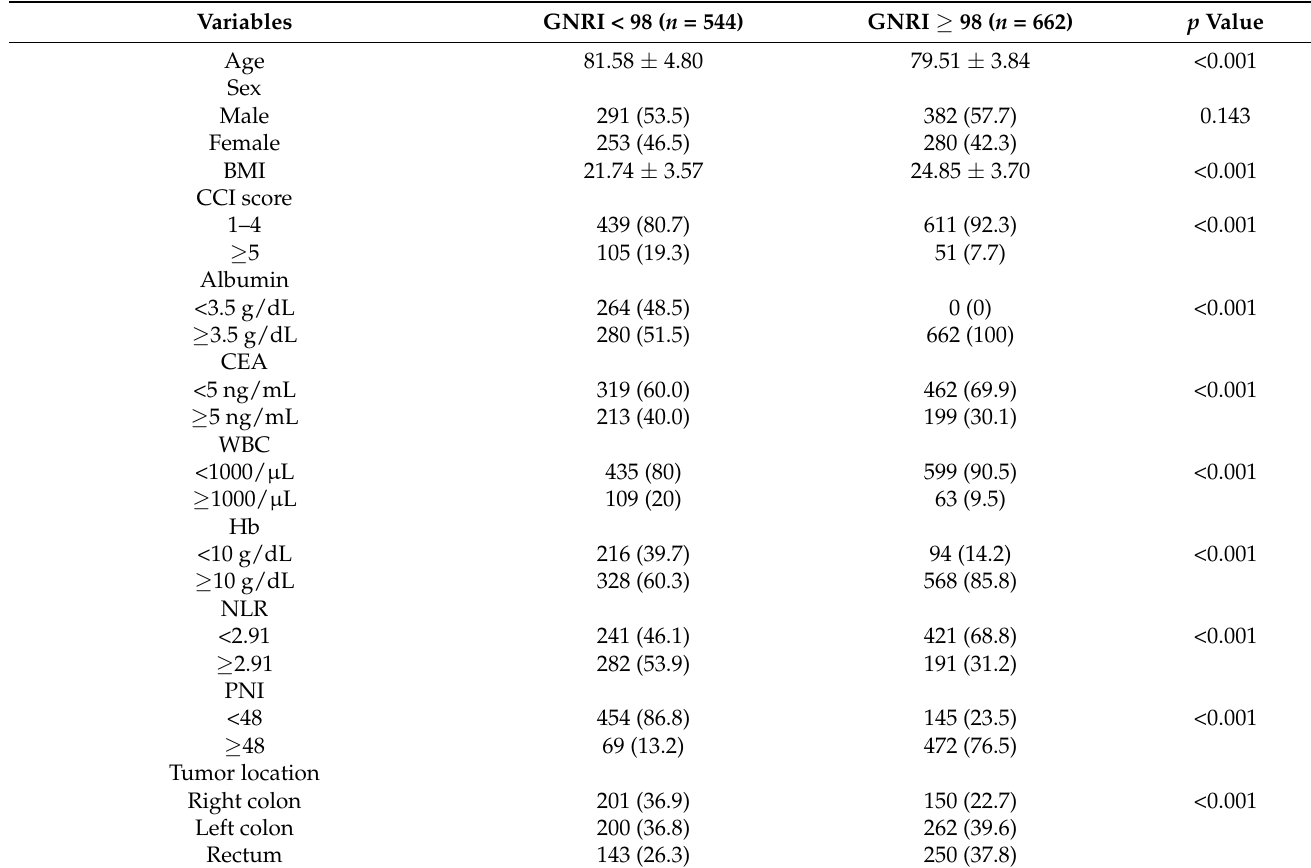
Table 3. The association of GNRI and postoperative complications in 1206 patients with CRC un- dergoing curative resection.